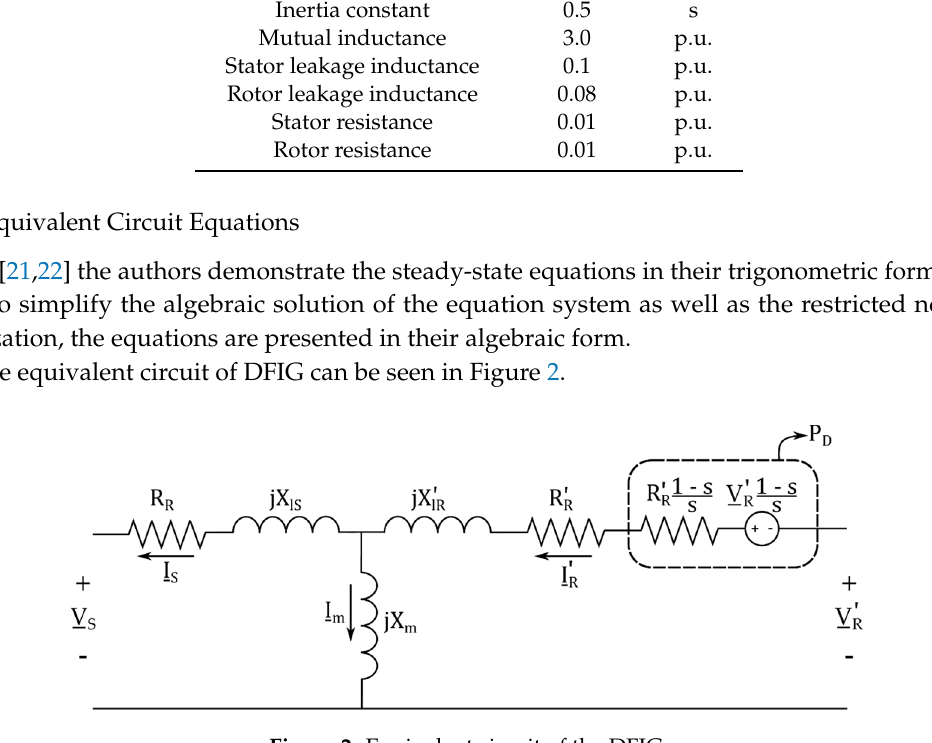
Figure 2. Equivalent circuit of the DFIG.